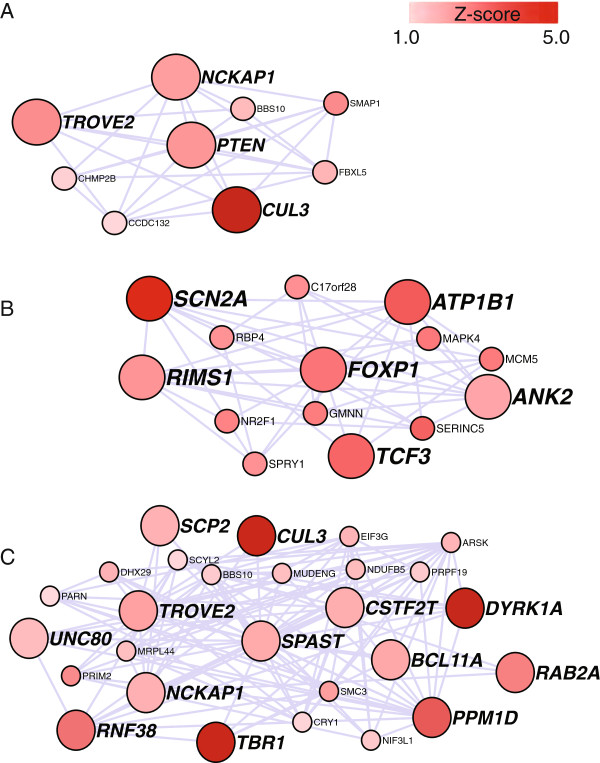
Gene subnetworks for thePTEN,FOXP1 andSPAST genes. Figure shows all rASD genes with absolute correlation of.7 or better with (A)PTEN, (B)FOXP1 and (C)SPAST. Intensity of red color reflects the magnitude of the Z-score from the TADA statistic. Large nodes with labels depict genes that have at least one dnLoF mutation recorded in the current literature (except PTEN). ANK2, CUL3, DYRK1A, SCN2A and TBR1 are genes with multiple dnLoF mutations. ANK2 is included along with rASD genes because it has two dnLoF mutations.